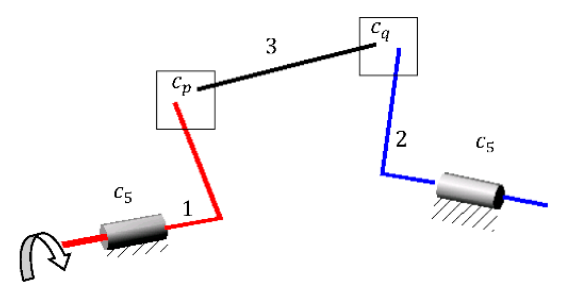
Figure 4. Two shafts (elements 1 and 2) coupled by an intermediate element (3).